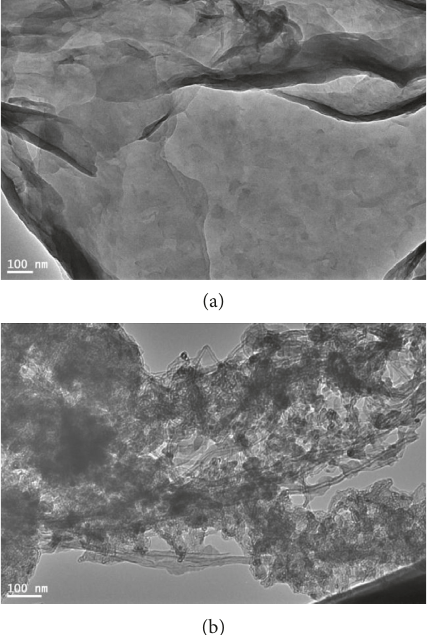
Figure 2: TEM images of PE obtained by Cp 2.5 wt.% CNT (b) and control